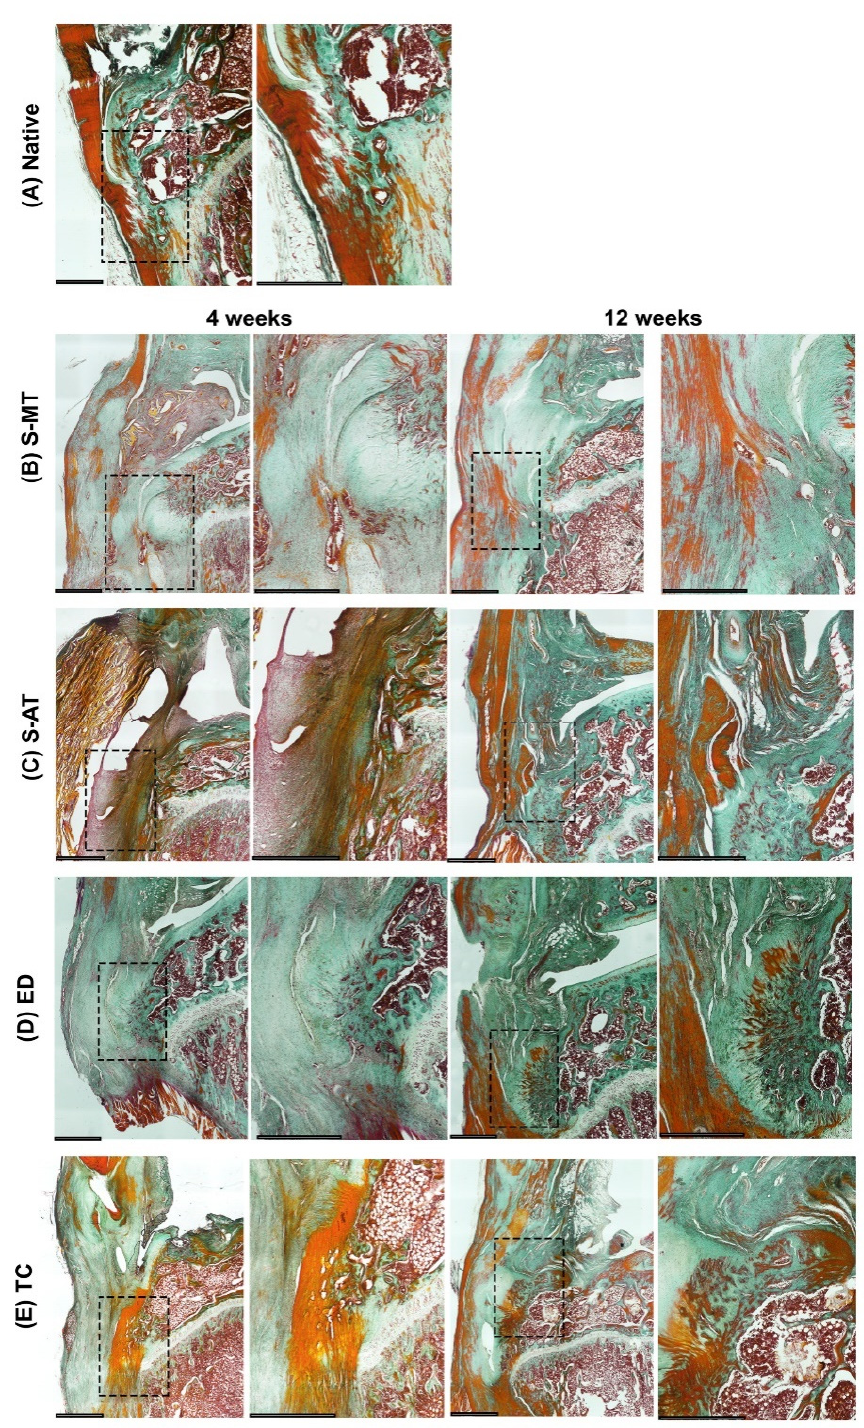
Figure 6. Masson–Goldner trichrome staining. Representative images of the histological analysis of enthesis defects at the patellar region at 4 (left pairs) and 12 weeks (right pairs) after surgery, in ( A ) native enthesis, ( B ) S-MT with mixed transition, ( C ) S-AT with abrupt transition, ( D ) empty defect, and ( E ) transversal cut at enthesis site. Dense collagen areas appear dark green, cartilage and newly formed collagen-rich tissue appears pale green. Muscle and cell cytoplasm are stained red. Dashed squares in the left pairs indicate the locations of the zoomed-in areas shown on the respective right. Scale bars = 800 µm.